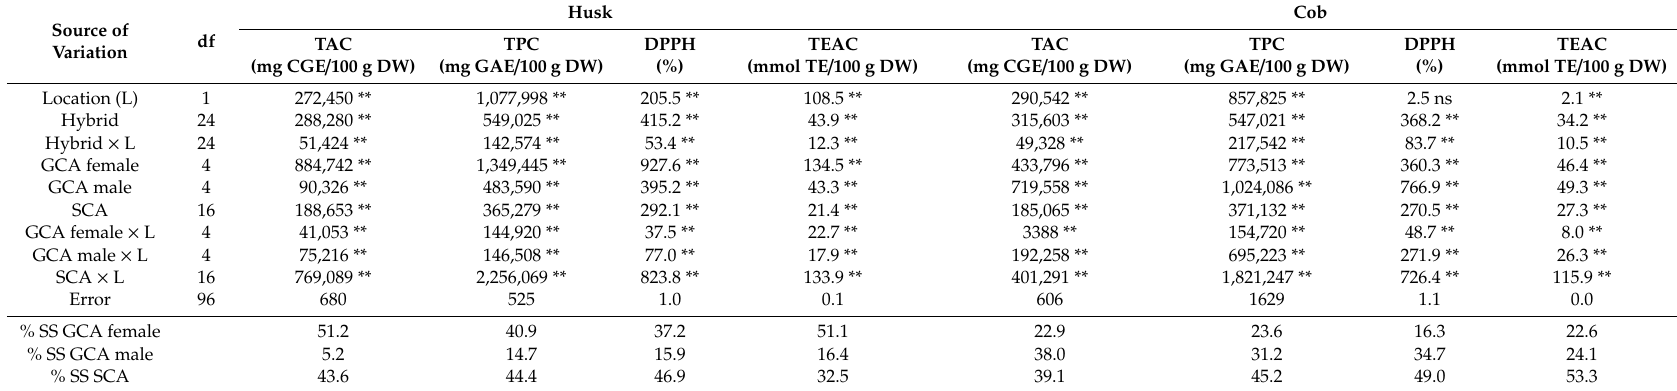
Table 3. Sums of squares for total anthocyanin content (TAC), total phenolic content (TPC), and antioxidant activity determined by (2,2-diphenyl-1-picrylhydrazyl) (DPPH) and trolox equivalent antioxidant capacity (TEAC) method of parents and their hybrids evaluated across two locations. Source of